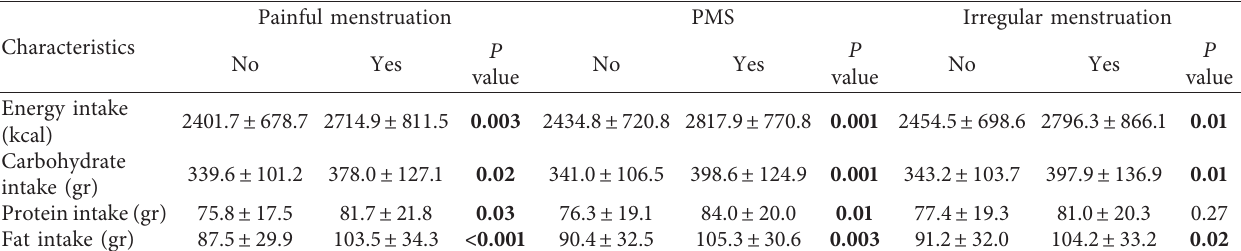
Table 4: Various menstrual disorders across energy and macronutrient intake. Characteristics